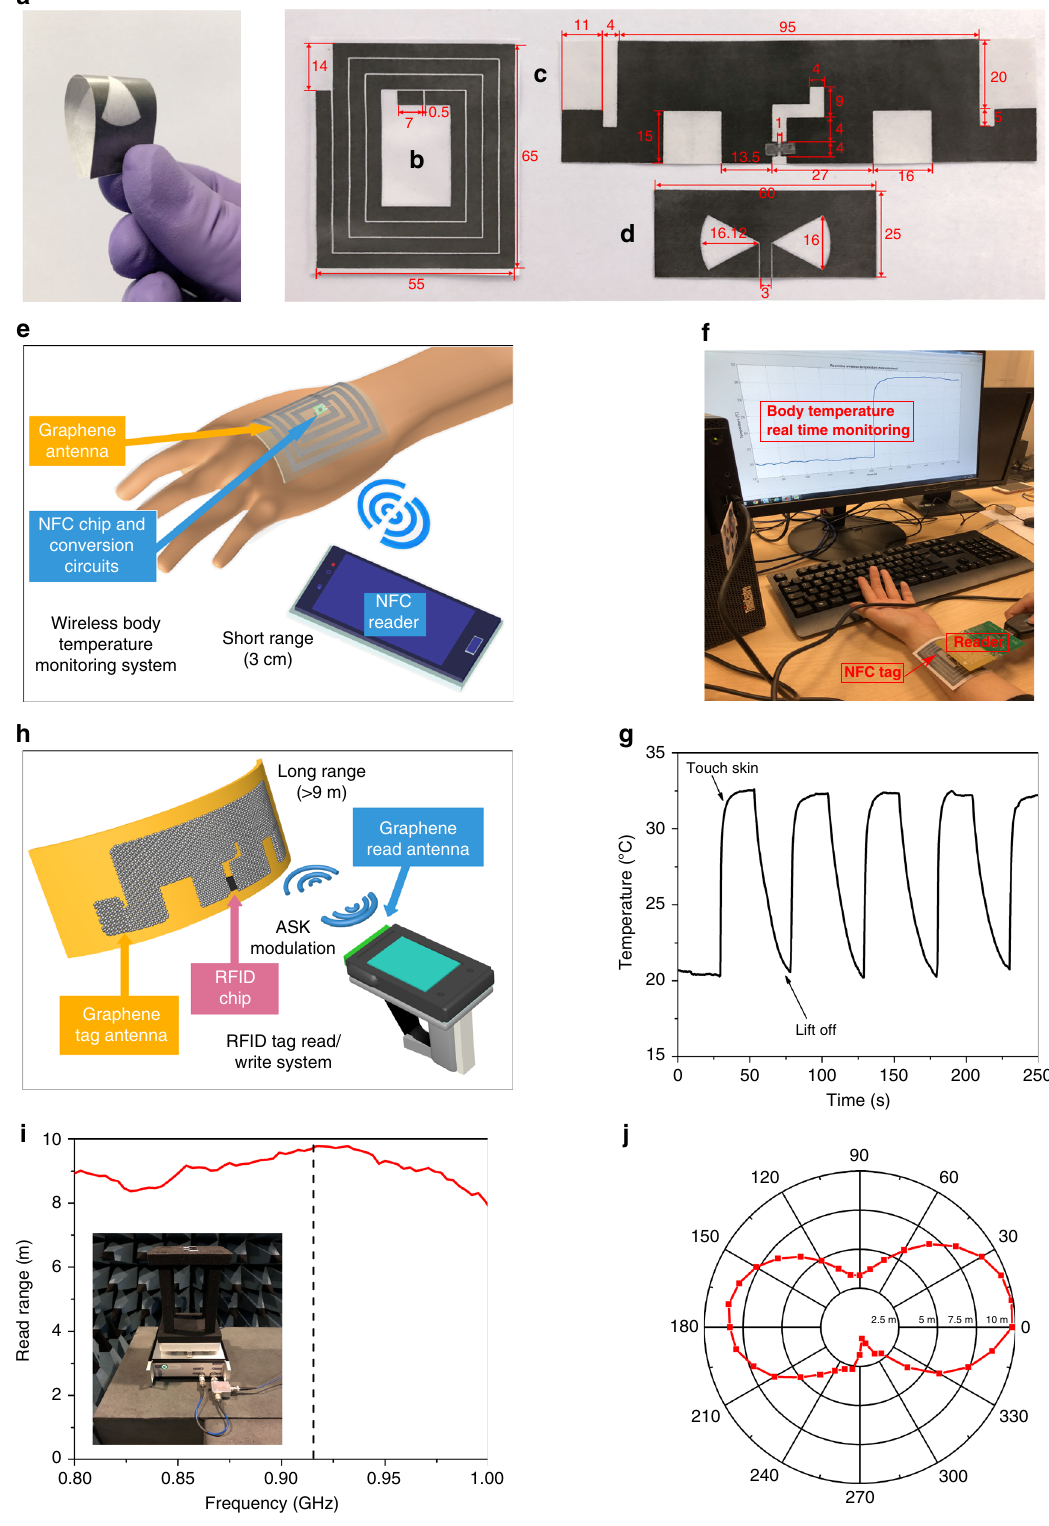
Fig. 4 Printed graphene antennas and IoT applications. a Flexibility of the printed graphene antenna. b – d Printed graphene antennas ’ geometric parameters (mm): b NFC antenna (without NFC chip and jumper), c UHF RFID antenna, d wideband slot antenna. e – g Healthcare applications ( e Illustration of graphene printed NFC temperature sensing system, f Demonstration of measurement and g recorded data of body temperature). h – j UHF RFID tag applications demonstration ( h Illustration of printed graphene RFID antenna system, i Read range and j radiation pattern (E- fi eld, at 915